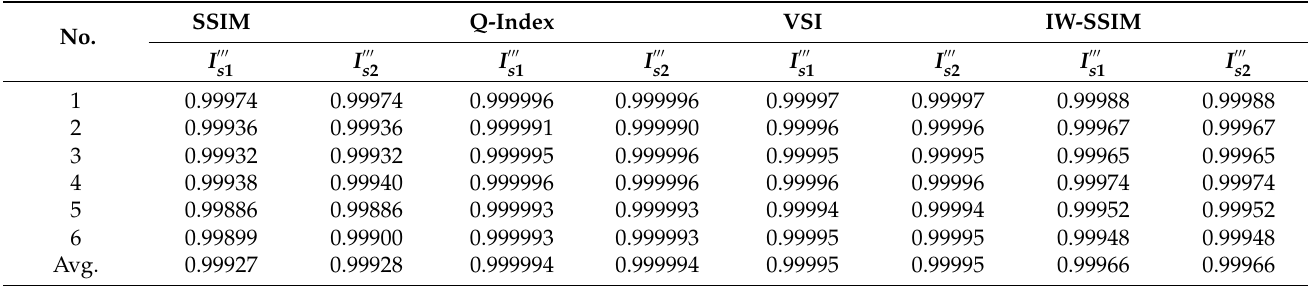
Table 11. Full-reference image quality assessment for six test stego